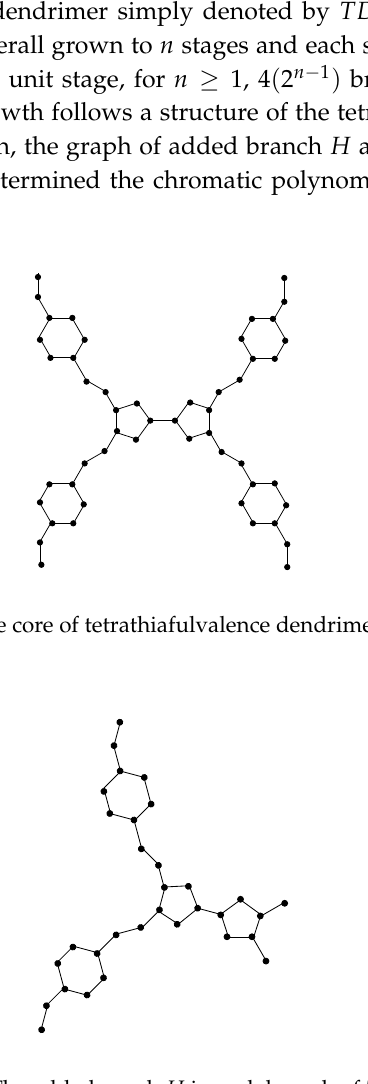
Figure 11. The added graph H in each branch of TD 2 [ n ]